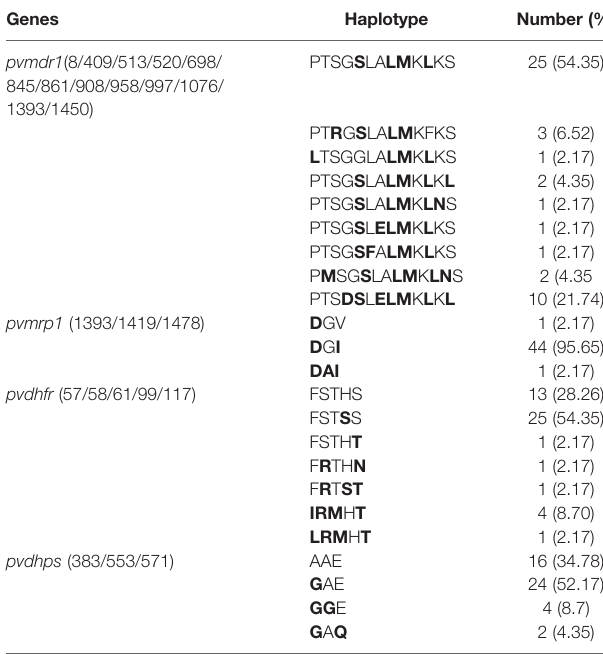
TABLE 2 | The prevalence of pvmdr1 , pvmrp1 , pvdhfr and pvdhps genes substitutions in 46 parasite isolates and association of the mutations with altered ex vivo drug susceptibilities.